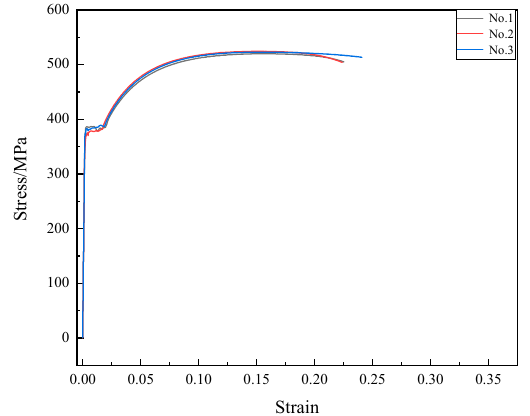
Figure 2. Stress–strain relationship for Q345qD specimen.